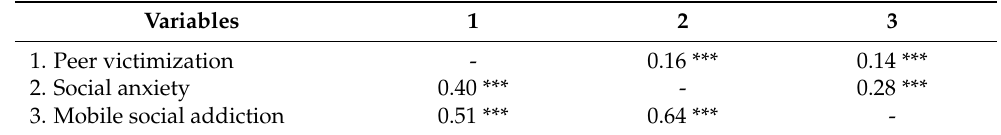
Table 2. Intercorrelations between